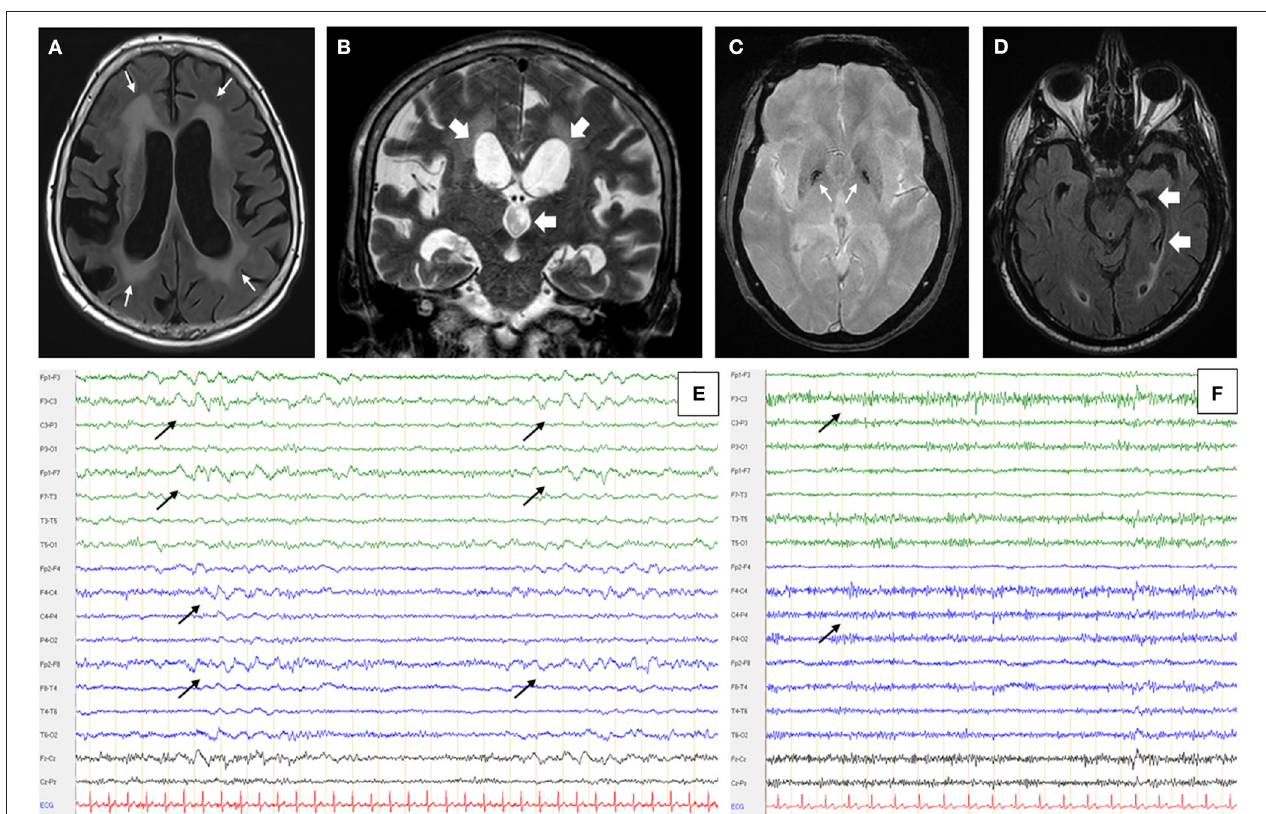
FIGURE 1 | Patient’s MRI and EEG. Patient N ◦ 1 brain MRI in axial FLAIR (fluid attenuated inversion recovering) sequence (A) and coronal T1 weighted sequence (B) showed periventricular confluent leukopathy (thin white arrows - A), cortical and subcortical atrophy predominant on the right hemisphere and a significant dilatation of lateral and third ventricles (large white arrows - B). (C) Patient N ◦ 2 had a hyposignal of the two pallidal tips in axial T2* sequence (white arrows). (D) Hippocampal atrophy, predominant on the left side, on patient’s N ◦ 3 axial FLAIR MRI (white arrows). All MRI were performed on 3 Tesla devices (Magnetom Skyra, Siemens Healthcare, Erlangen, Germany and Achieva 3.0T, Philips, Amsterdam, Netherlands). (E) Patient N ◦ 1 also had recurrent bilateral anterior delta waves on a 6.5Hz basic rhythm (black arrows). (F) Patient N ◦ 2 had a non-pharmacological, bilateral and anterior fast rhythm at 14Hz (black arrows). EEGs were performed and read on